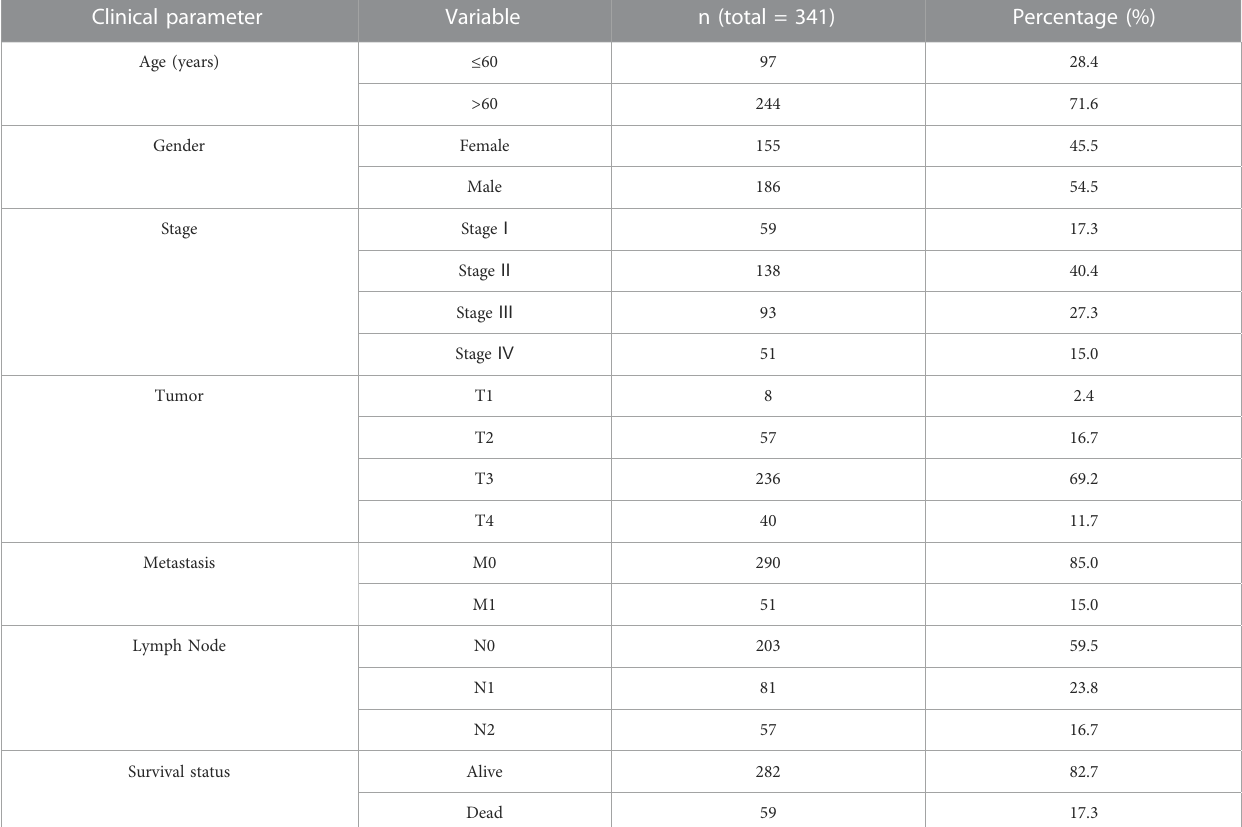
TABLE 1 Summary of the clinical data of The Cancer Genome Atlas (TCGA) colon adenocarcinoma